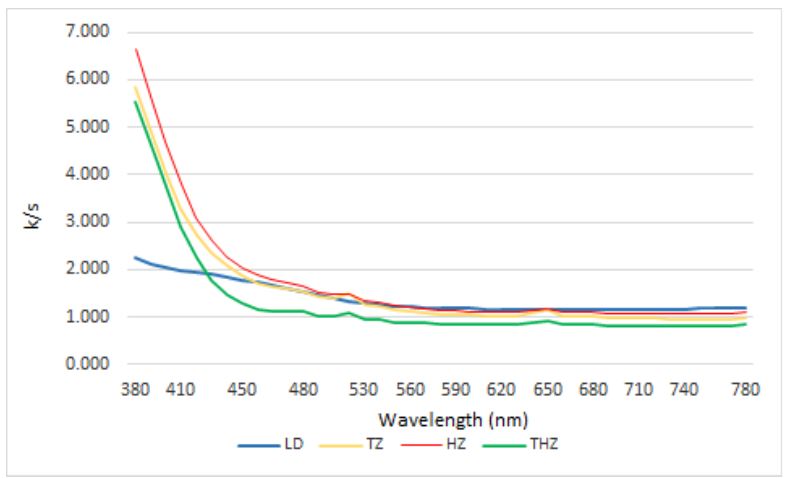
Figure 1. Reflectance spectra of the three samples, as mean of all measurements: ( a ) Reflectance